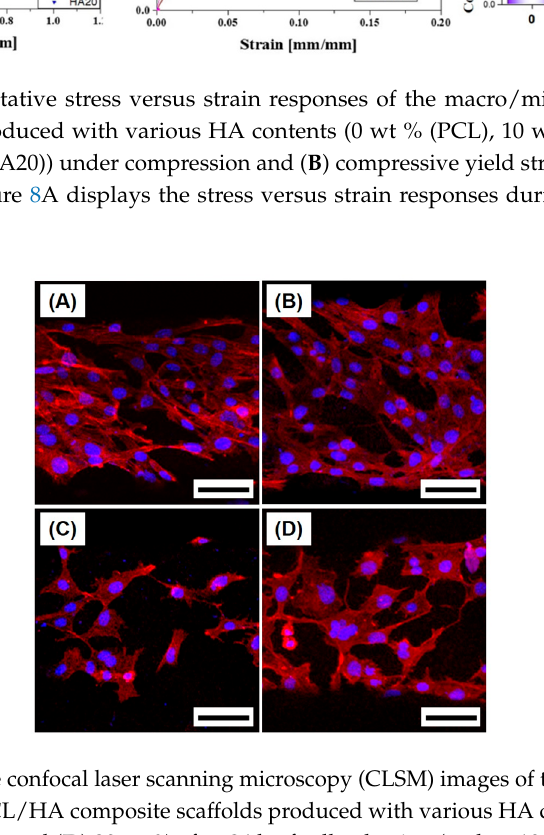
Figure 8. Representative confocal laser scanning microscopy (CLSM) images of the MC3T3-E1 cells on macro/micro-porous PCL/HA composite scaffolds produced with various HA contents of ( A ) 0 wt %; ( B ) 10 wt %; ( C ) 15 wt %; and ( D ) 20 wt % after 24 h of cell culturing (scale = 100 µm).